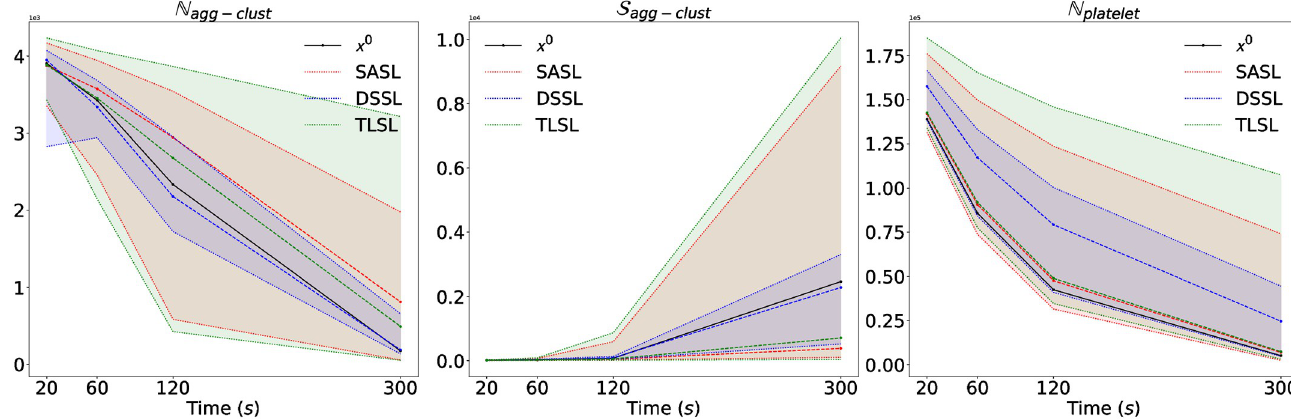
Fig 7. Comparison of predictive performance of SASL, DSSL and TLSL. The experimental data (black solid line), 95% predictive credibility interval (colored shaded area) and the median prediction (colored dashed line) for SASL (red), DSSL (blue) and TLSL (green) are illustrated to compare the predictive performance of SASL, DSSL and TLSL summary learning approach for N